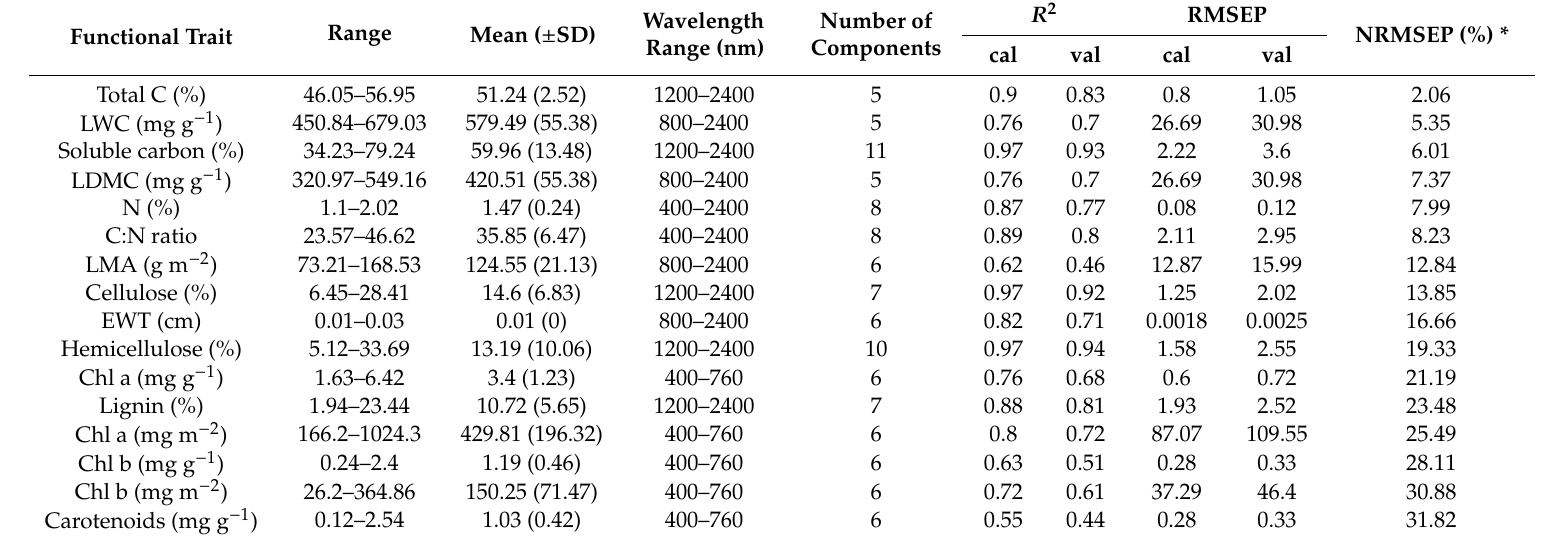
Table 3. Statistics for partial least square regression (PLSR) models predicting functional traits from